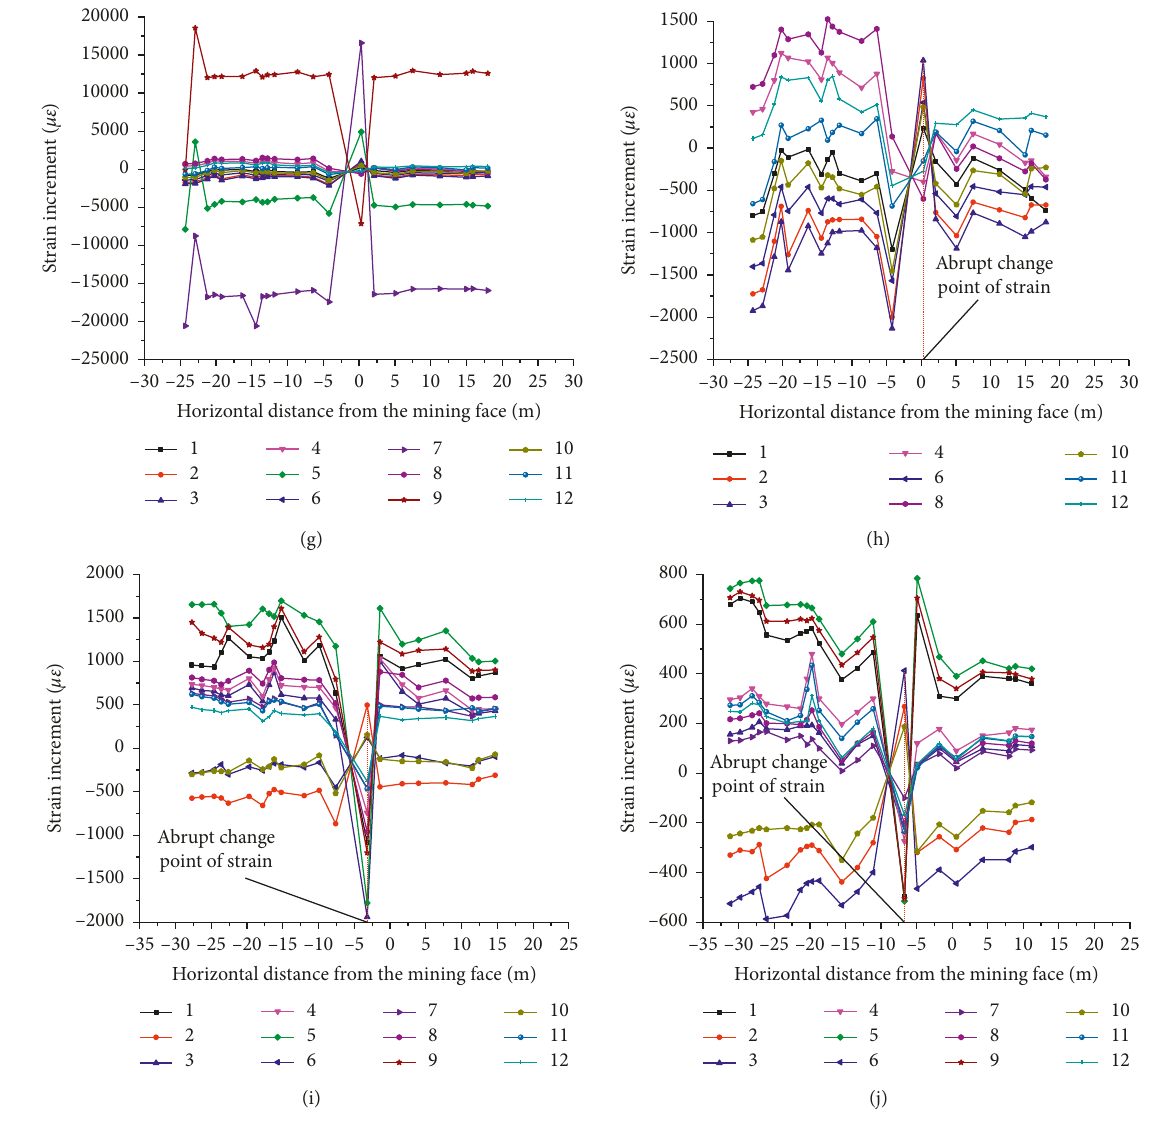
Figure 5: Strain increment curves of each sensor in boreholes I and II in the 100502 (80m) mining face. (a) Sensor #1. (b) Sensor #2. (c) Sensor #3. (d) Sensor #4. (e) Sensor #5. (f) Sensor #6. (g) Sensor #7. (h) Sensor #7 after abnormal data are removed. (i) Sensor #8. (j) Sensor